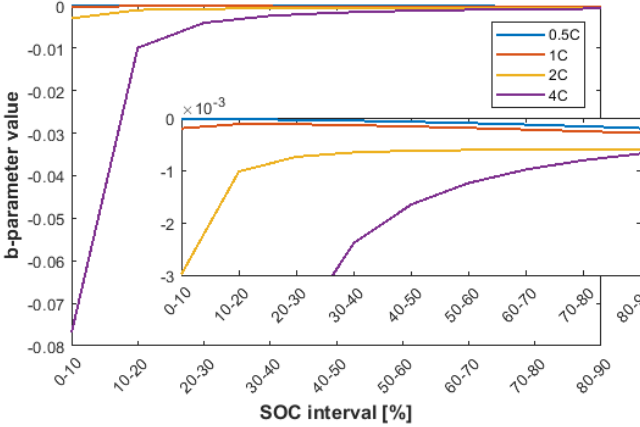
Figure 4. SOC and C-rate dependence for the b parameter in the ageing function. Table 2. Look-up table for SOC and temperature dependency for parameter d .